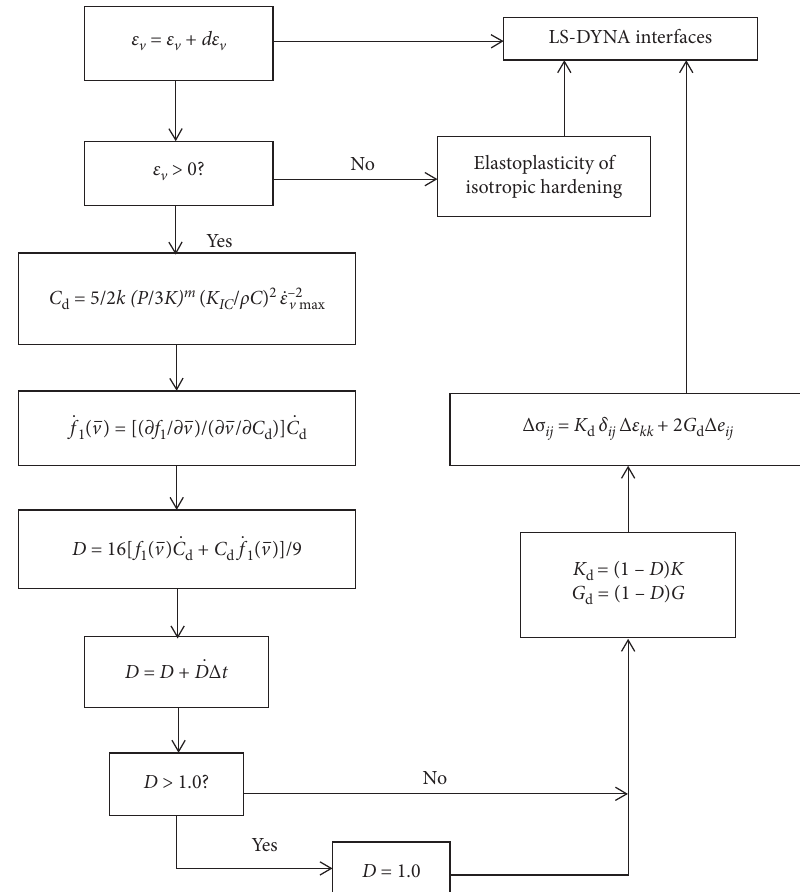
Figure 7: Flowchart of the damage model.